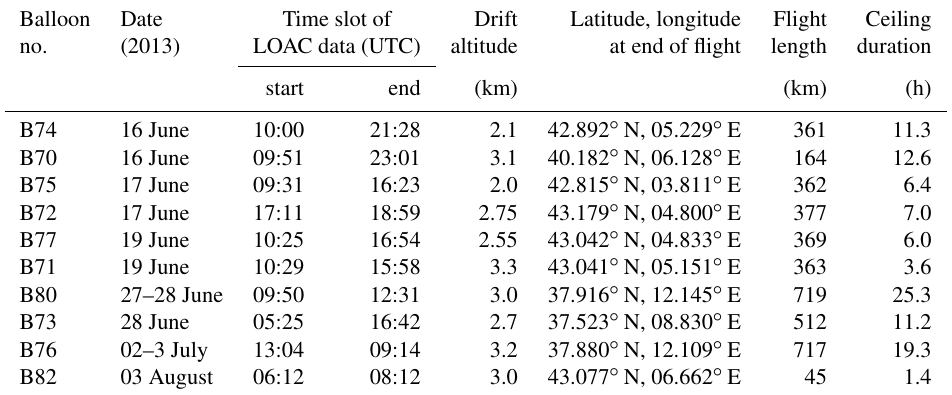
Table 2. List of the 10 LOAC flights aboard drifting boundary layer pressurised balloons (BLPBs) flown during African dust plume events of the ChArMEx summer 2013 campaign. All balloons were launched from Minorca Island (Spain; 39.865 ◦ N, 4.254 ◦ E) except B82 that was launched from the Ile du Levant (France; 43.022 ◦ N, 6.460 ◦ E).